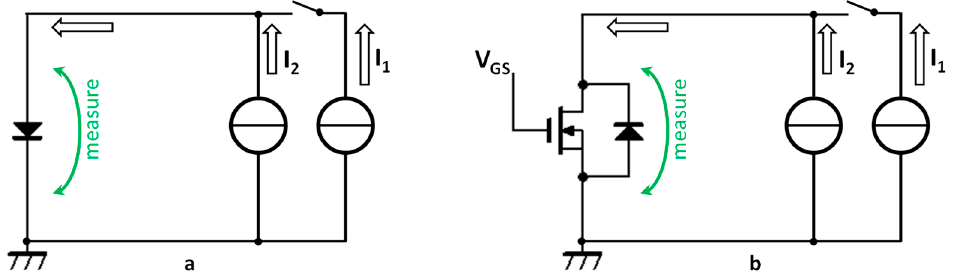
Figure 11. Powering scheme for the thermal transient measurement of a diode ( a ) and an IGBT in saturation mode ( b ).